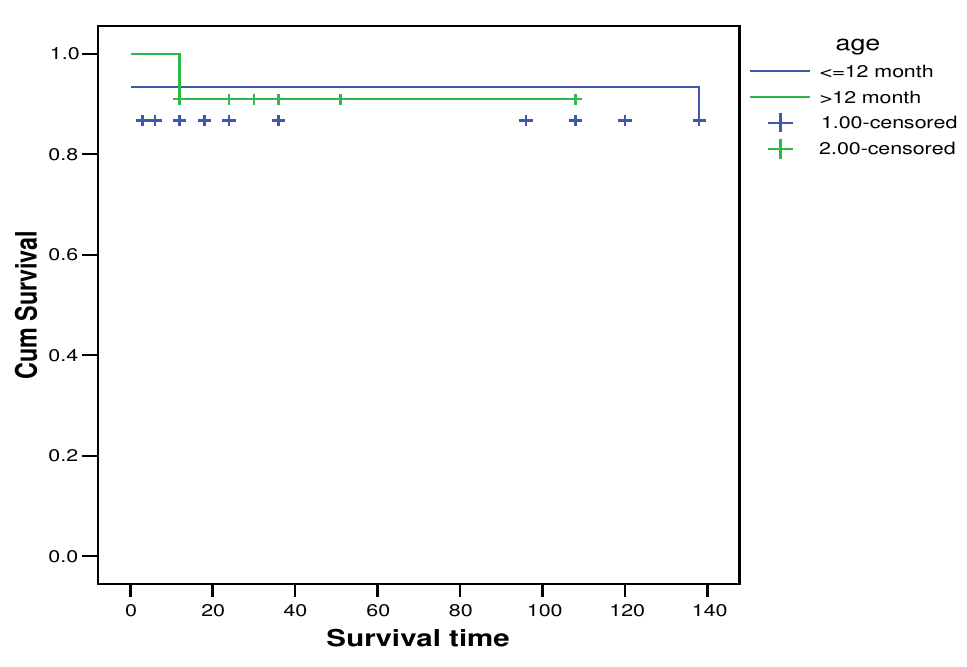
FIGURE 8. Kaplan-Meier analysis of survival after DCM diagnosis. Included different causes of DCM in children: vira , familial, and idiopathic forms of DCM. (Copyright reserved for the author: Dr. Galal Eldin Nagib